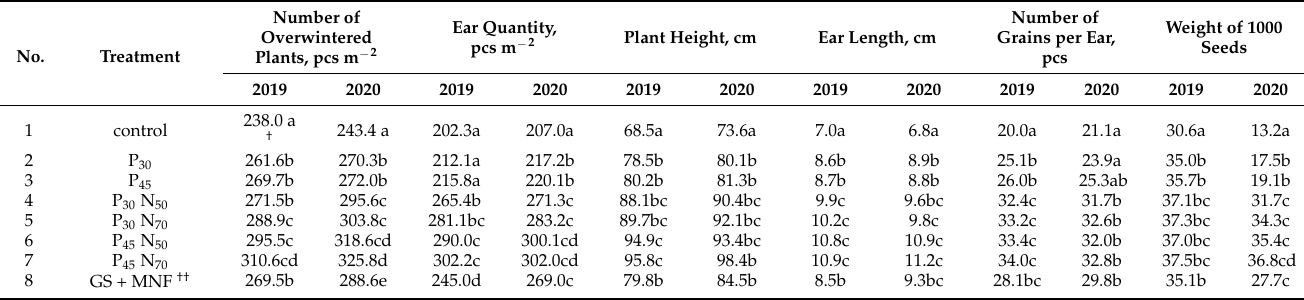
Table 4. Biometric indicators of the rainfed winter wheat development with direct sowing and various fertilization in South